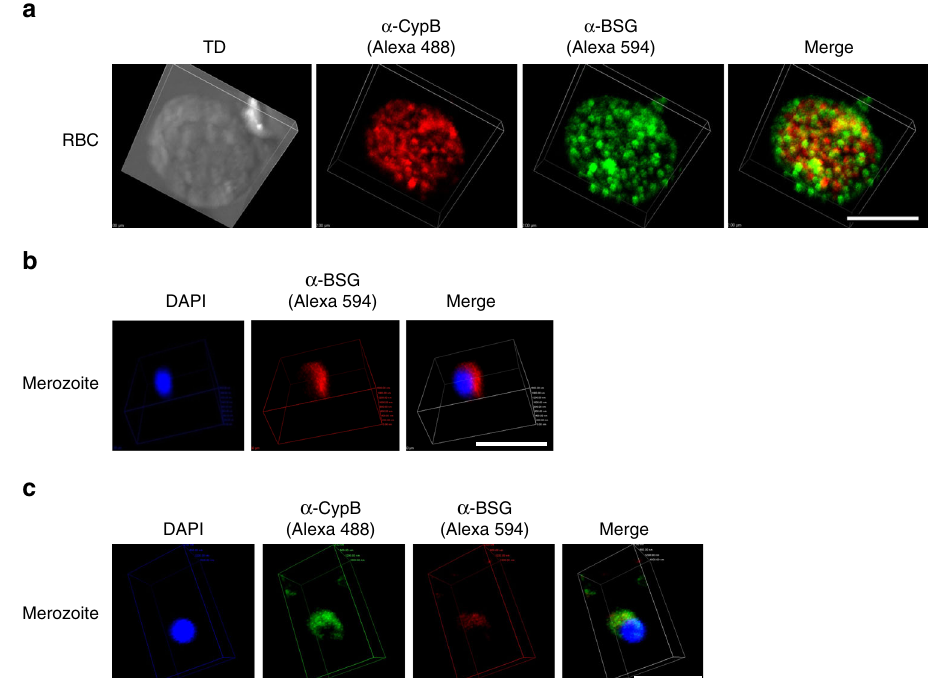
Fig. 4 Cyclophilin B interacts with Basigin (CD147/BSG), a critical merozoite invasion receptor on RBCs. a Co-localization of CypB and BSG on the surface of the RBC. RBCs were fi xed and incubated with anti-CypB (mouse monoclonal) and anti-BSG (rabbit polyclonal) antibodies. The cells were stained with fl uorochrome-conjugated secondary antibodies against CypB (green) and BSG (red) followed by confocal microscopy. CypB and BSG co-localized on the RBC surface with a Pearson ’ s coef fi cient of 0.53. b Merozoites were incubated with 25 µ M of BSG protein for 2 h and detection was carried out using anti- CD147 antibody (rabbit polyclonal) and secondary fl uorochrome-conjugated (red), followed by confocal microscopy. c CypB and BSG bind together on the merozoite surface. Merozoites were incubated with CypB and BSG proteins (25 µ M each) for 2 h and binding was detected using anti-CypB (mouse monoclonal) and anti-BSG (rabbit polyclonal) antibodies followed by secondary antibodies and confocal microscopy. Supplementary Fig. 5 illustrates in vitro interaction assays between CypB and BSG. Scale bar = 5 µ